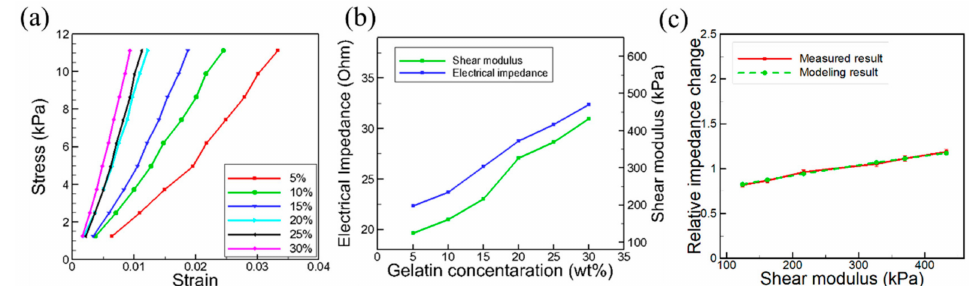
Figure 4. ( a ) The stress-strain measurement result for test samples with di ff erent weight ratios; ( b ) the measured electrical impedance and shear modulus of as a function of gelatin concentration; ( c ) the measured and calculated relative electric impedance shift of the bulk crystal. The calculated result was obtained from Equation (4).